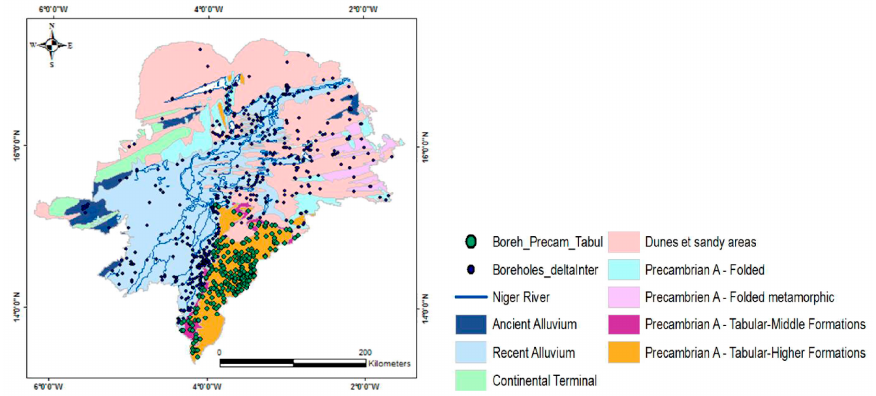
Figure 9. Location of boreholes on the lithological background.